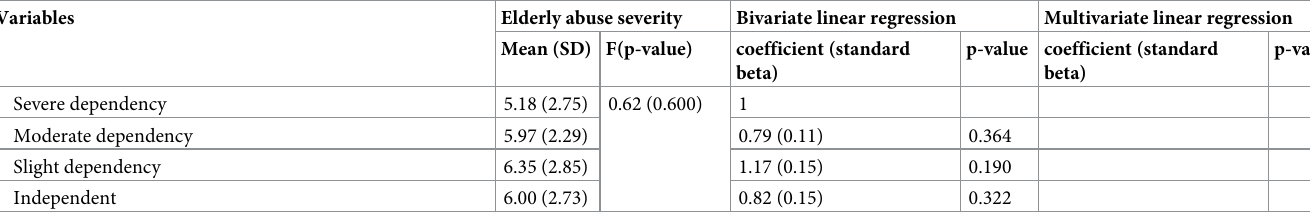
95% CI: 0.14–0.52, p < 0.001). However, individuals who reported the presence of a perpetrator and those with slight or moderate functional dependence were likely to experience neglect. The likelihood of experiencing neglect was highest in individuals with moderate functional dependence (aOR = 9.33, 95% CI: 2.15–40.42, p = 0.003). This final model had a sensitivity of